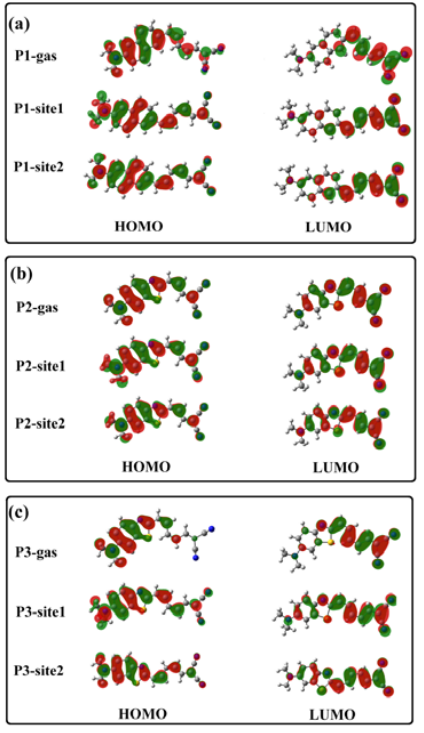
Figure 5. HOMO and LUMO for ( a ) P1, ( b ) P2, and ( c ) P3 in the ground state in different Figure5. HOMOandLUMOfor( a )P1,( b )P2,and( c )P3inthegroundstateindifferentmicroenvironments. microenvironments. Table 2. OPA wavelength λ OPA (nm), oscillator strength δ OPA (a.u.), transition nature, and the dipole moment µ (Debye) for P1, P2, and P3 in di ff erent microenvironments in long wavelength region. H(L) denotes